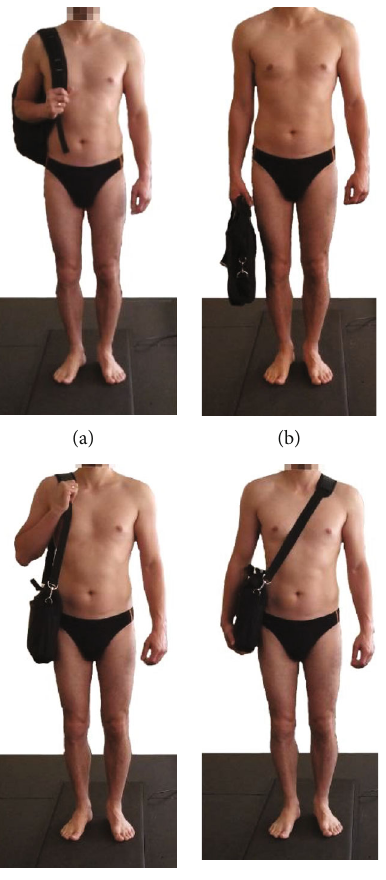
Figure 1: Four investigated methods of carrying the load: (a) backpack on one shoulder, (b) bag in one hand, (c) bag on one shoulder, and (d) bag with strap across